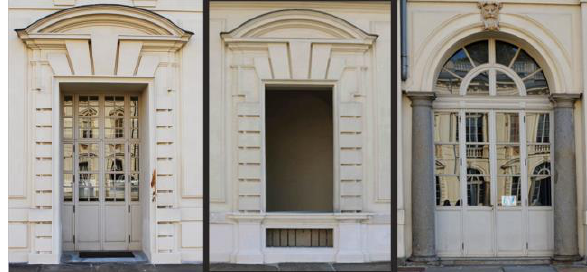
Figure 2. View of some of the analyzed architectural elements Within this research we take into consideration windows and doors facing the court (Figure 2), these are architectural elements dating back to Seventeenth